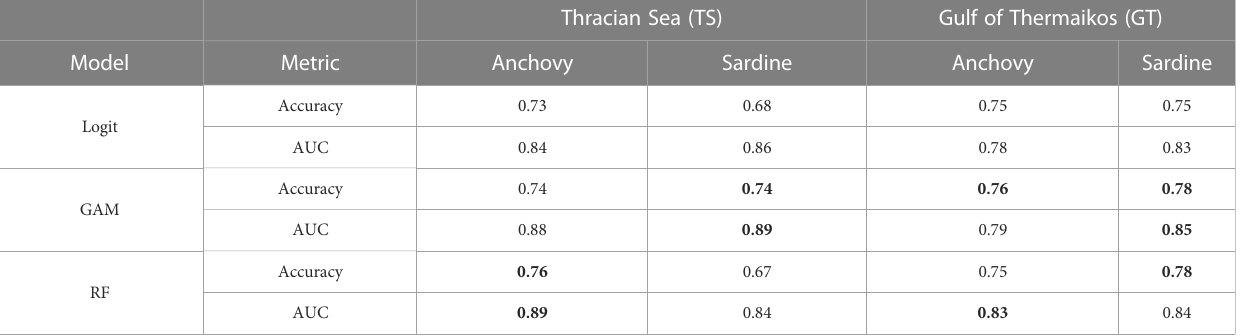
TABLE 1 Accuracy and AUC scores for each model of anchovy and sardine.